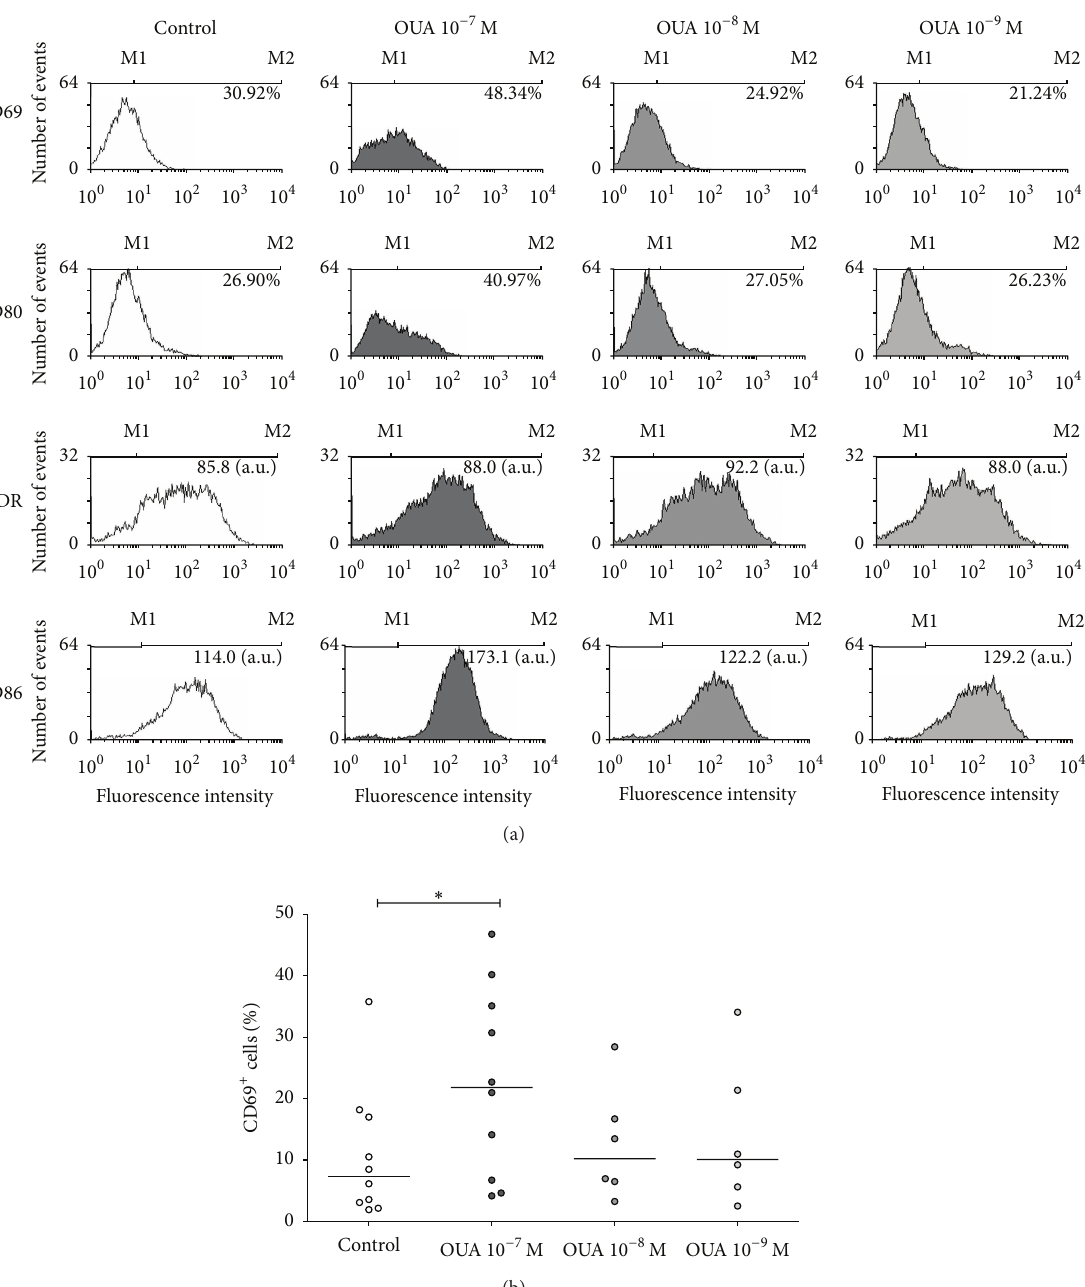
Figure 2: Ouabain dose response curve on the expression of activation and costimulatory molecules by monocytes. Cells were cultured in the absence or presence of 10 −7 M, 10 −8 M, and 10 −9 M of ouabain for 24 hours. After 24 hours, these cells were incubated for 30 minutes with specific antibodies, as previously described. (a) Histograms show the patterns of CD69, CD80, HLA-DR, and CD86 expression on monocytes untreated or treated with different concentrations of ouabain. Values of CD69 + and CD80 + cells and mean fluorescence intensity of HLA-DR + and CD86 + cells were also added to the histograms. Control and OUA 10 −7 M, 𝑛 ≥ 6 ; OUA 10 −8 and 10 −9 M, 𝑛 = 1 , with the exception of CD69 experiments ( 𝑛 ≥ 6 ). (b) Data are expressed as the percentage of CD69 + monocytes and lines refer to the median of ten (Control and OUA 10 −7 M) or six (OUA 10 −8 and 10 −9 M) independent experiments. ∗ 𝑃 < 0.05 using both repeated measures ANOVA with Dunnett’s posttest (when analyzing only corresponding data) and two-tailed paired t -test (when analyzing all